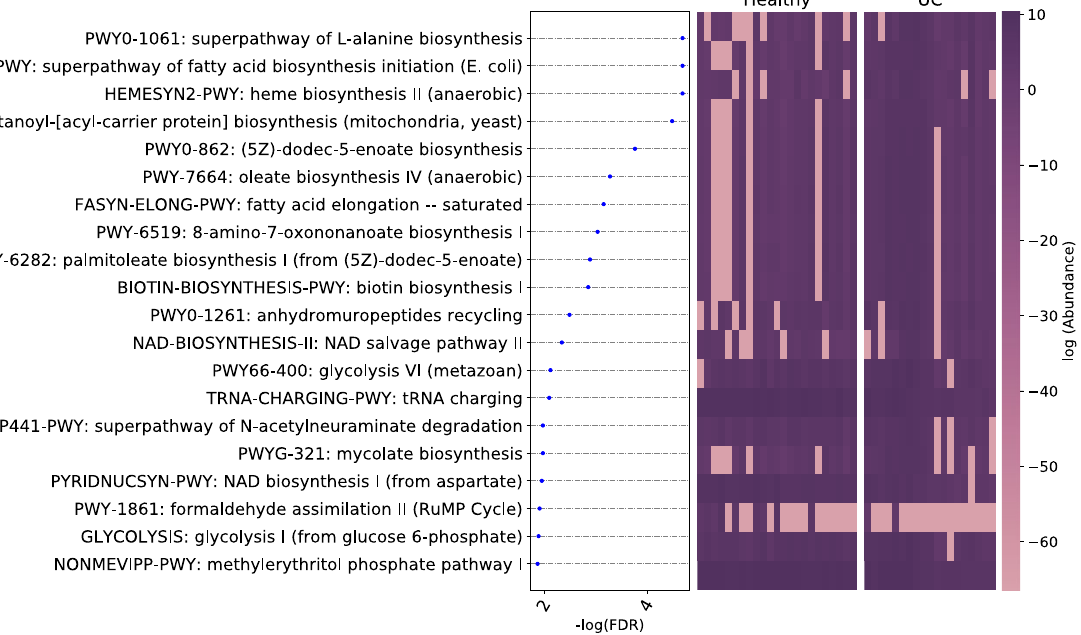
Figure 5. Pathways associated with pediatric UC ranked according to their statistical significance and heatmap using the shotgun pathway abundance.